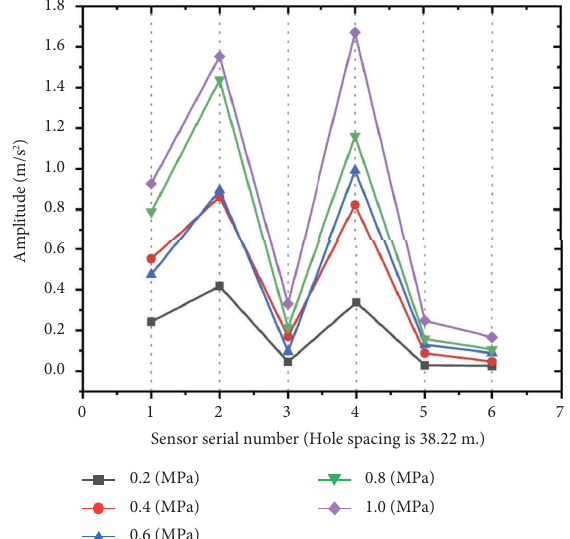
Figure 5: Variation of the amplitude of A and C leakage with the distance under diferent pressures.